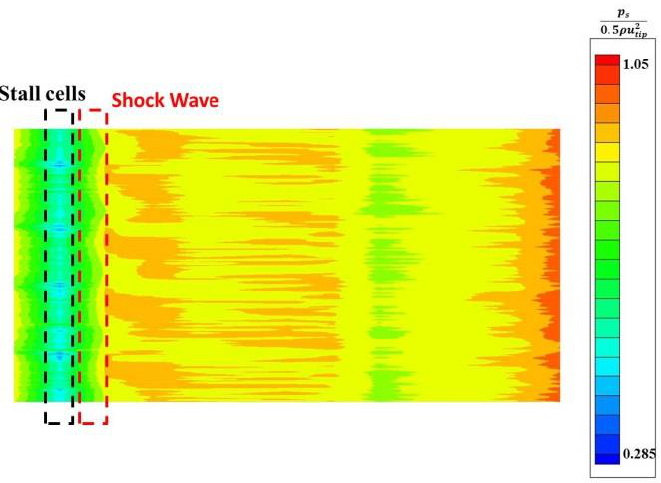
Figure 24. The distribution of the pressure coefficient inside R1, at the surge limit.